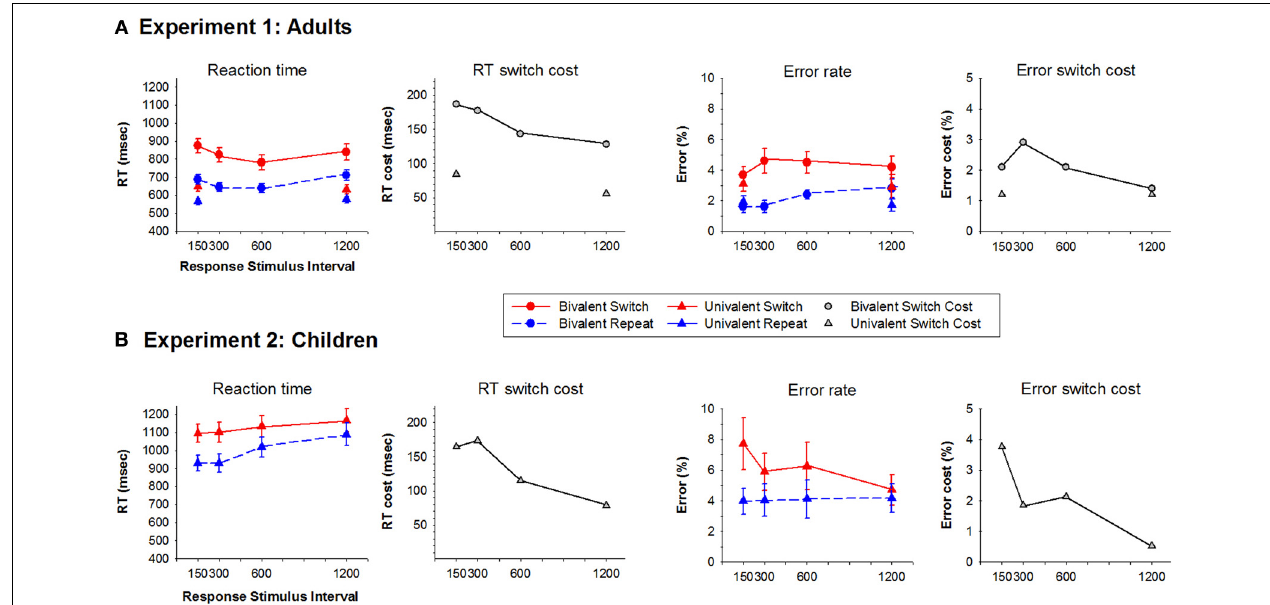
FIGURE 2 | Average reaction time and error rate for switch and repeat trials and their switch cost at each RTI condition for Experiments 1 (Adults) (A) and 2 (Children) (B). Circles represent bivalent stimulus blocks and upward triangles represent univalent stimulus